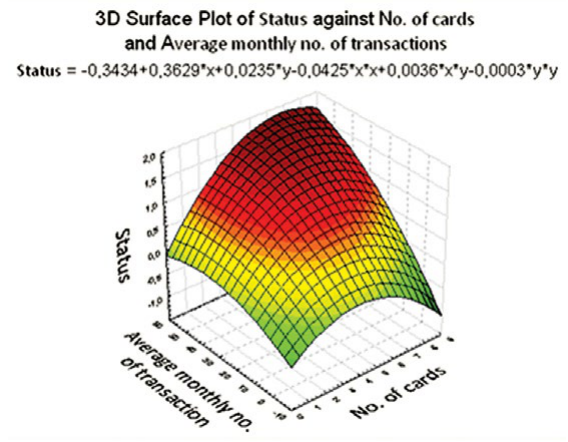
Fig. 3. Status against two predictors – 3D